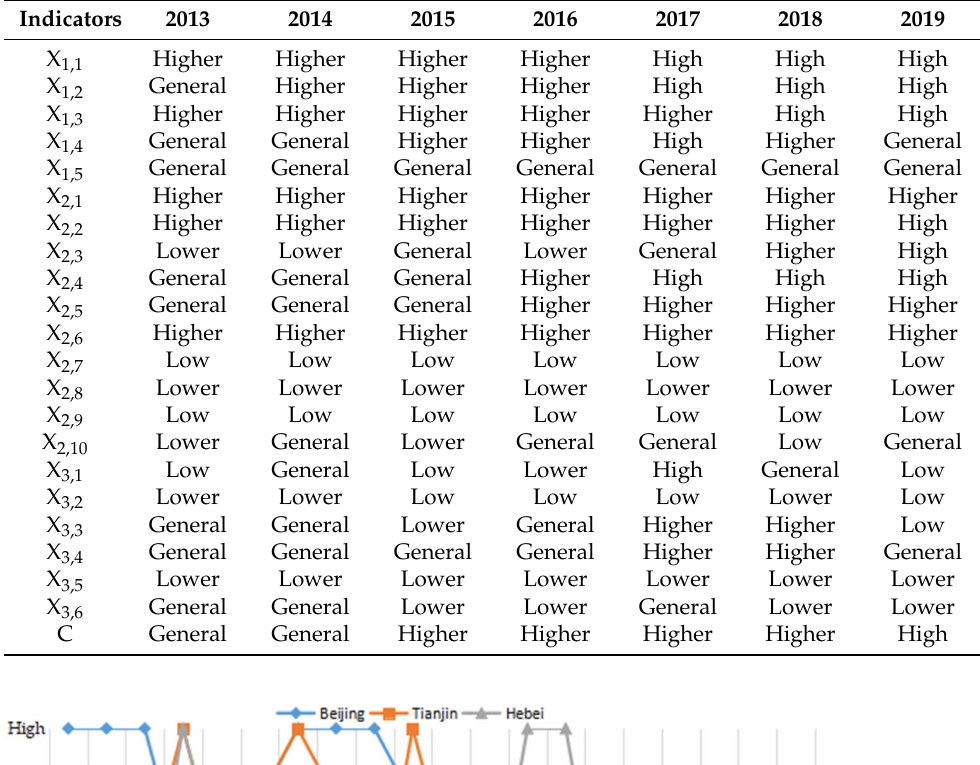
Table 13. Evaluation level of each indicator in Beijing region for example.